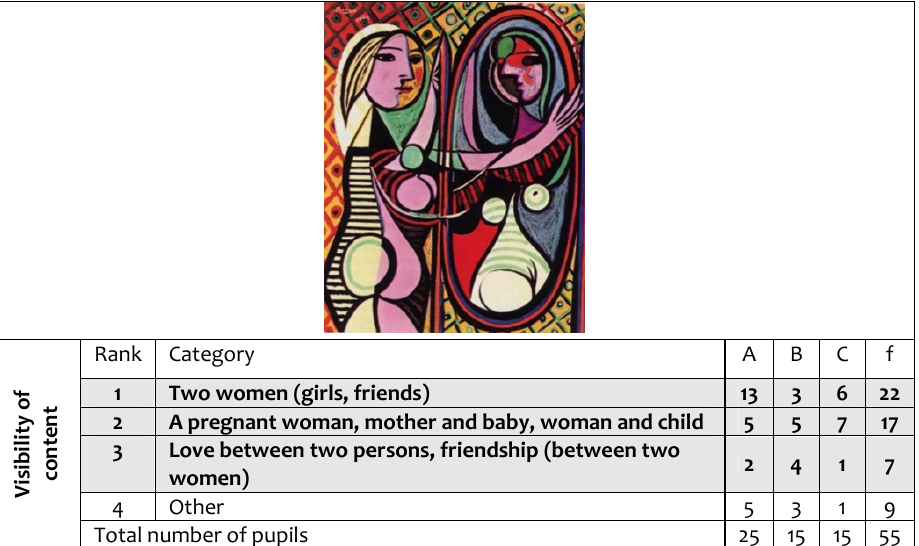
Table 8: Ranking order of the categories of answers regarding the visibility of the content of the third example (Pablo Picasso, Girl before a Mirror,